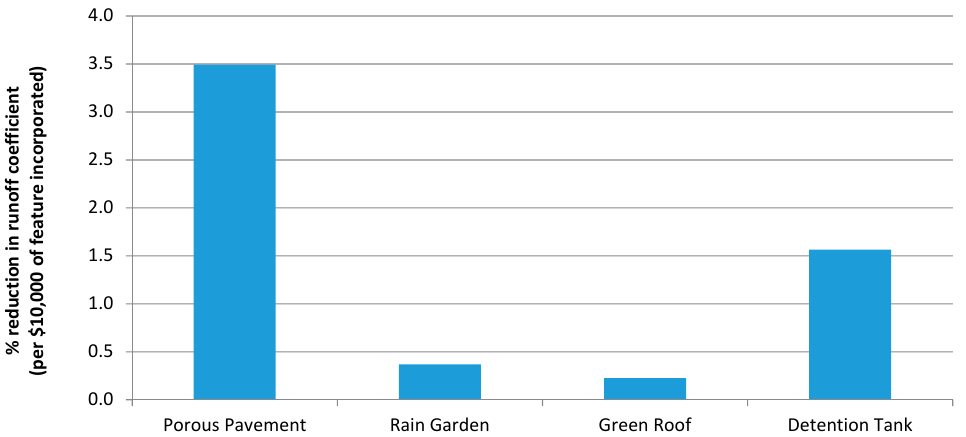
Figure 16. Percentage reduction in C for every SGD$10,000 of features incorporated.